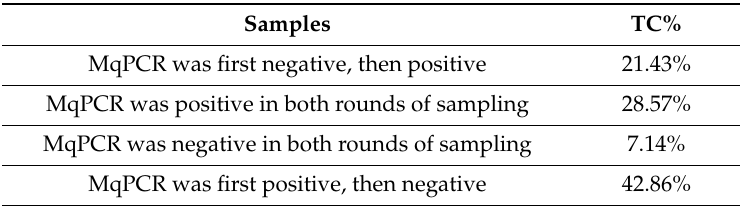
Figure3. Thresholdcycle(TC)changesofBTMsoverMqPCRanalysison14sheepherdsinalongitudinal study (two instances of sampling). At first, 42.86% of BTMs were recognized as positive by qPCR, then changed to negative at the second trial. In total, 28.57% were qPCR-positive in both trials. However, the higher concentrations of DNA (1.05 × 10 2 ng / µ L > C < 5.25 × 10 − 6 ng / µ L) corresponding to lower TC values (15–34 cycles) were visible in the second trial. Table 2. Distribution of BTMs from 14 sheep herds (28 BTMs) in four categories based on MqPCR status (positive / negative) in a longitudinal